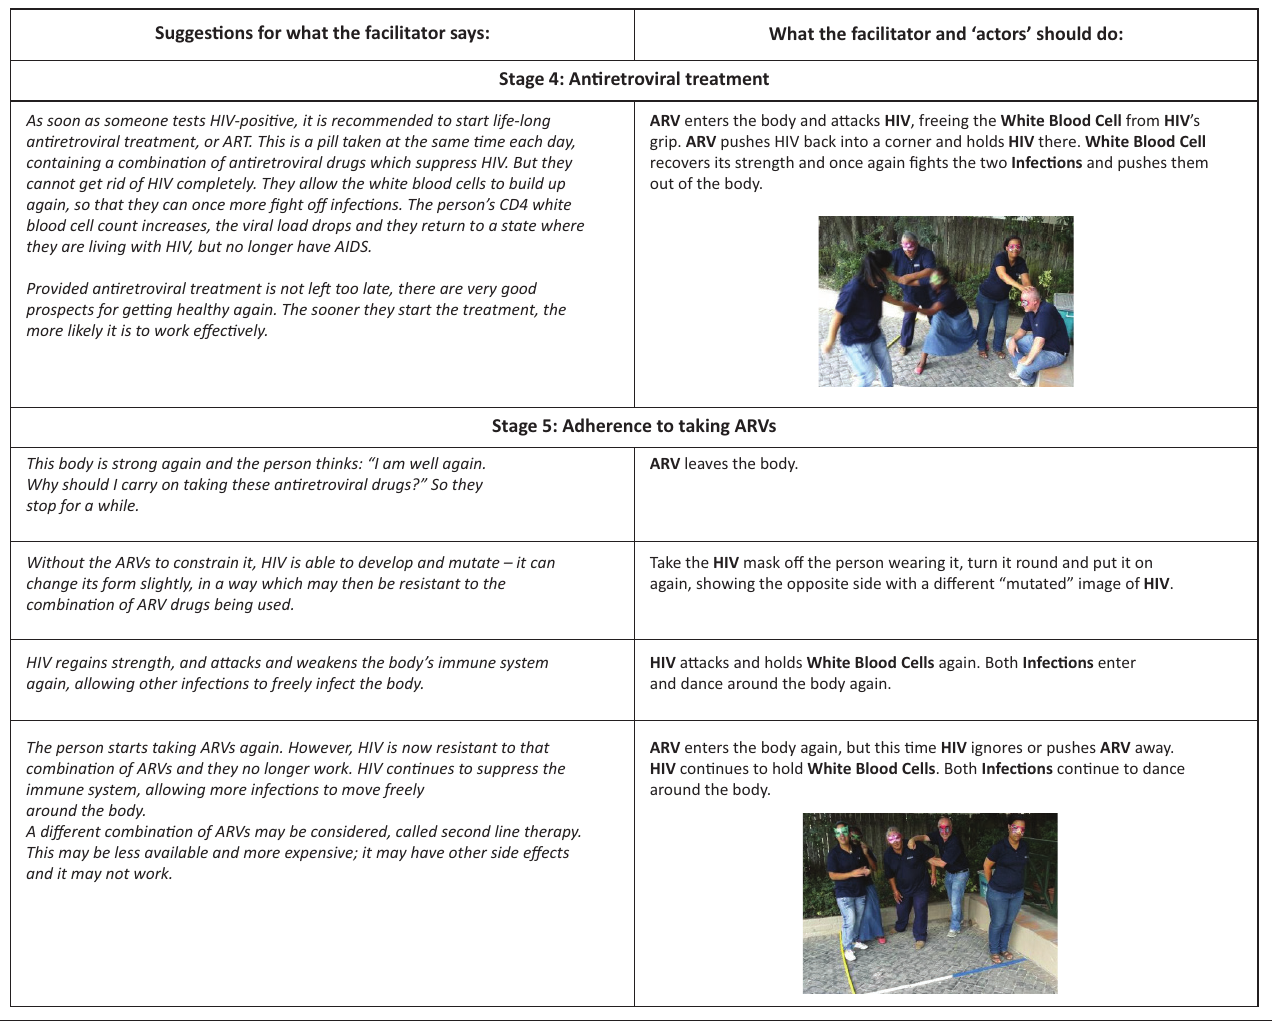
FIGURE 1: Antiretroviral treatment and adherence game (a description of the antiretroviral treatment adherence game, extracted from the Bridges of Hope’s training